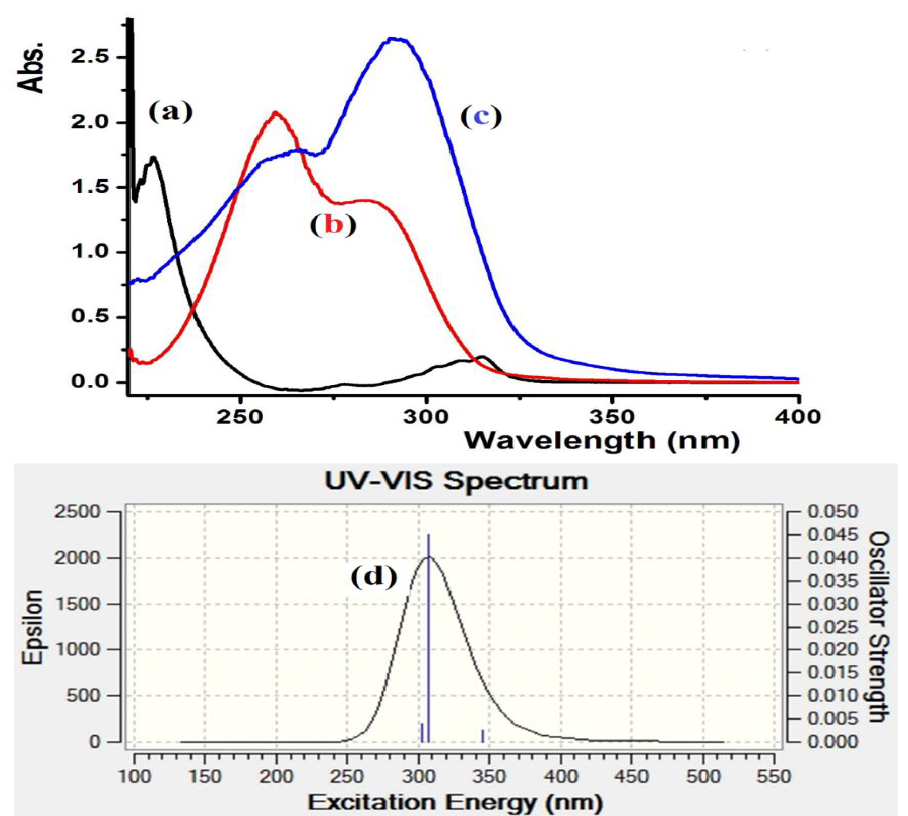
Figure 4. UV–Vis. spectroscopy spectra of: (a) 2-(Piperidin-4-yl) ethanamine, (b) 5-bromothiophene-2-carbaldehyde, (c) experimental of L3 in ethanol and (d) TD-DFT/B3LYP/6-311++(d,p) of L3 in ethanol.